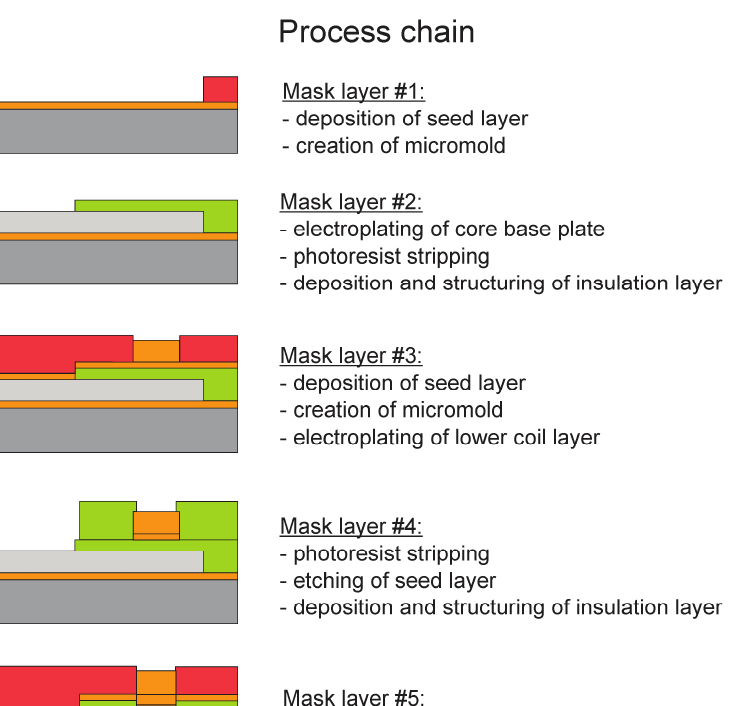
Figure 3. Basic process chain for fabrication of a double layer spiral microcoil with integrated NiFe